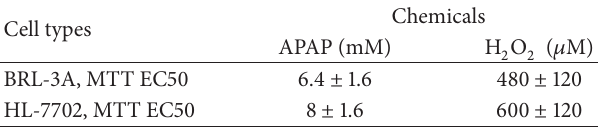
Table 1: The EC50 values of APAP and H 2 O 2 in inhibiting BRL-3A and HL-7702 proliferation determined by MTT